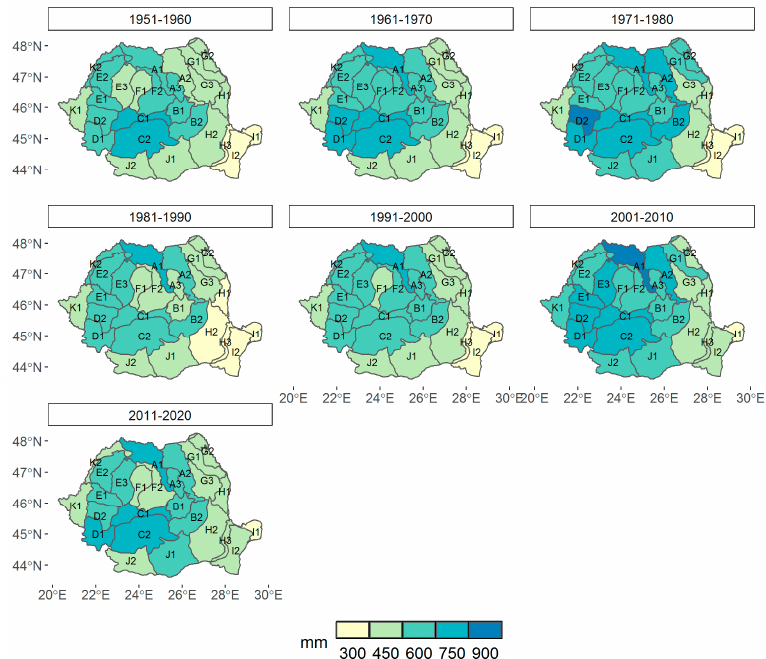
Figure 4. The variation of average annual precipitation on the decades for the provenance subregions.